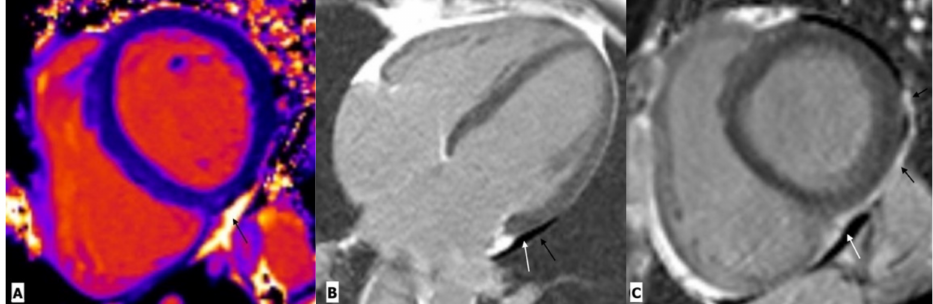
Figure 3. Cardiac magnetic resonance imaging in a 38-year-old man with HIV-related pericarditis and pericardial effusion. ( A ) Mid-ventricular short-axis view T1 map showing high signal intensity pericardial effusion (black arrow). ( B ) Four chambers view and ( C ) mid-ventricular short-axis view gadolinium enhancement images showing mild pericardial effusion (white arrow) with thickening and enhancement of pericardium (black arrow) along the left lateral LV